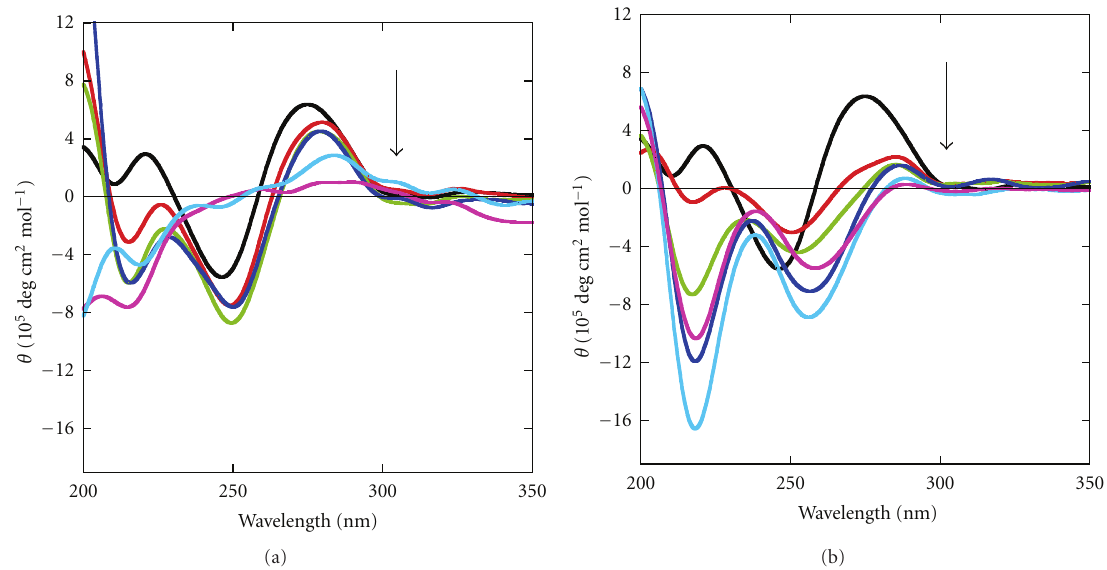
Figure 3: CD spectra of 1 μ M DNA frayed duplex. Measurements were carried out at 37 ◦ C in 30mM MES bu ff er (pH 7.0) containing 100mM Na + , 0.5 mM Na 2 EDTA, RecG (0nM) and ATP (0mM) (black), RecG (50nM) and ATP (0.1mM) (red), RecG (100nM) and ATP (0.2mM ) (green), RecG (150nM) and ATP (0.3mM, blue), RecG (200 nM) and ATP (0.4mM, cyan), and RecG (250nM) and ATP (0.5mM) (pink), at (a) 0 wt% PEG 200 and (b) 40wt% PEG